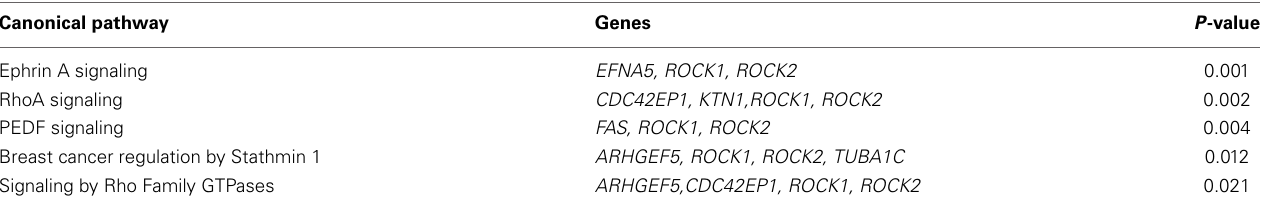
Table 10 | Canonical pathway analysis of the SSRI group.